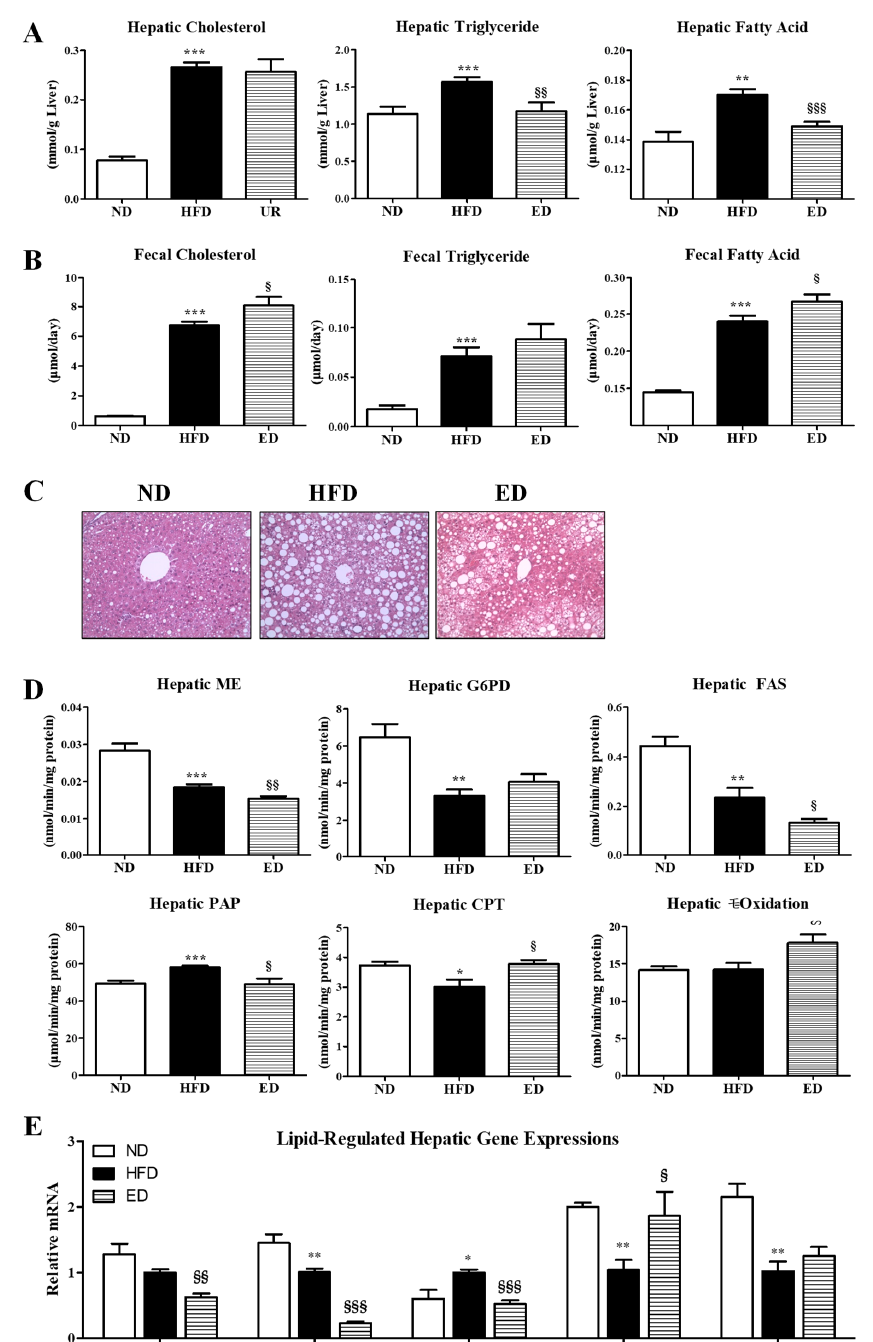
Figure 3. Effect of eriodictyol treatment on hepatic lipid levels ( A ), fecal lipid levels ( B ), hepatic morphology (200 × magnification) ( C ), activities of hepatic lipid-regulating enzymes ( D ), and expression of hepatic genes ( E ) in C57BL/6N mice fed with the high-fat diet (HFD). Data are presented as means ± SEM. Normal diet (ND; AIN-76) vs. HFD; * p < 0.05, ** p <0.01, *** p < 0.001. HFD vs. ED (HFD + 0.005% ED); § p < 0.05, §§ p < 0.01, §§§ p < 0.001. ME, malic enzyme; G6PD, glucose-6-phosphate dehydrogenase; FAS, fatty acid synthase; PAP, phosphatidate phosphohydrolase; CPT, carnitine palmitoyltransferase; SREBP1, sterol regulatory element-binding transcription factor 1; ACC, acetyl-CoA carboxylase; PPAR α , peroxisome proliferator-activated receptor α ; PGC1 α , PPAR- γ coactivator 1 α